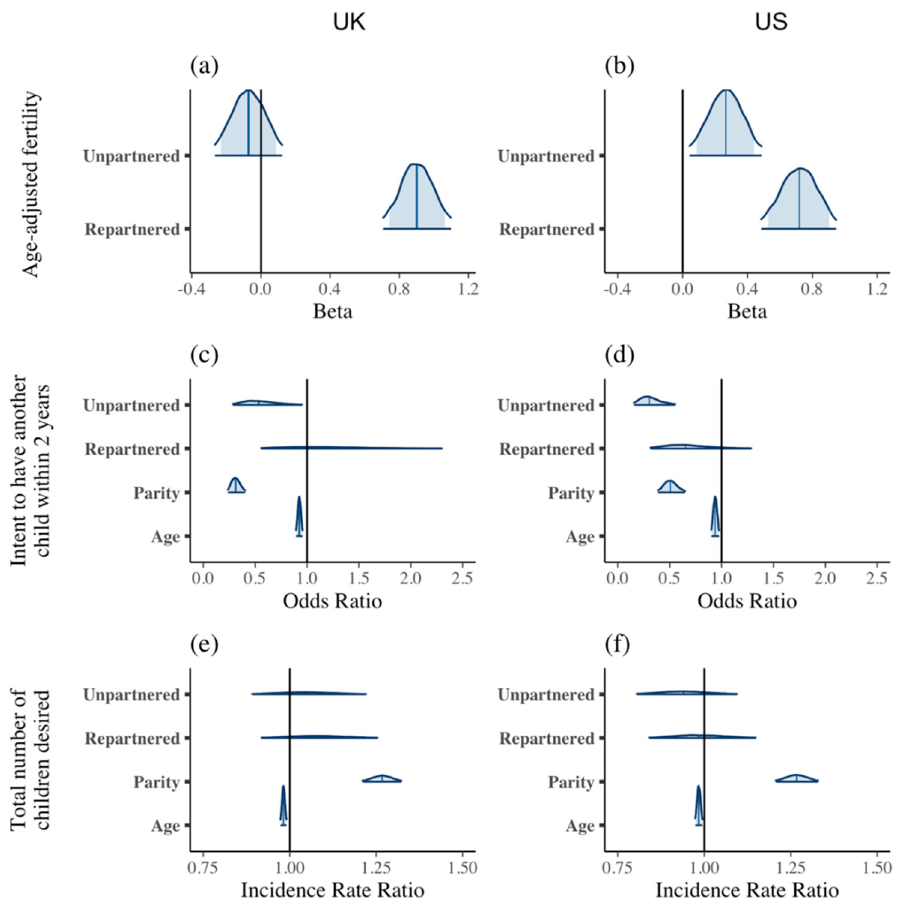
Figure 4. Plots showing the posterior distributions (95% credibility intervals) for the major predictors and control variables in the models for fertility outcomes using the following measures: ( a , b ) age-adjusted fertility; ( c , d ) intent to have another child within two years; and ( e , f ) total number of children desired. Reference category for unpartnered and repartnered women is partnered women; parity and age are entered as continuous predictors. Table 5. Results of Bayesian regression models predicting fertility outcomes in the US and in the UK. Intent to Have Another Child in Next 2 Age-Adjusted Fertility Total Number of Children Desired Years